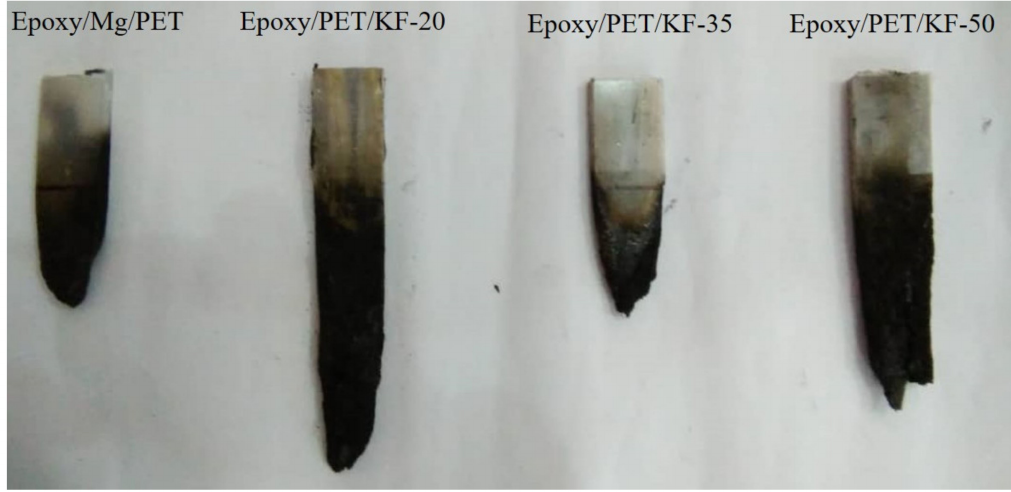
Figure 5. Samples of each composition after the burning